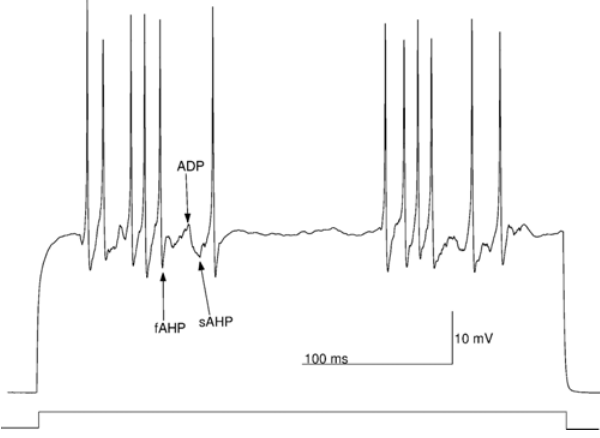
Figure 4. Exploring the intrinsic burst generation with the stochastic granule cell model. A small depolarizing current pulse (shown by a rectangular bar at the bottom of the figure) below firing threshold is injected into the cell soma. The bursts are evoked by random changes of s between the values s =0.3 and s =1.1 (i.e., during a burst the value of parameter s is increased to 1.1 otherwise it being 0.3). For illustrative purposes the trace with two bursts of action potentials is shown here (compare also with Figure 5). A fast afterhyperpolarization (fAHP), an afterdepolarization (ADP), and a slow afterhyperpolarization (sAHP) are indicated by arrows.